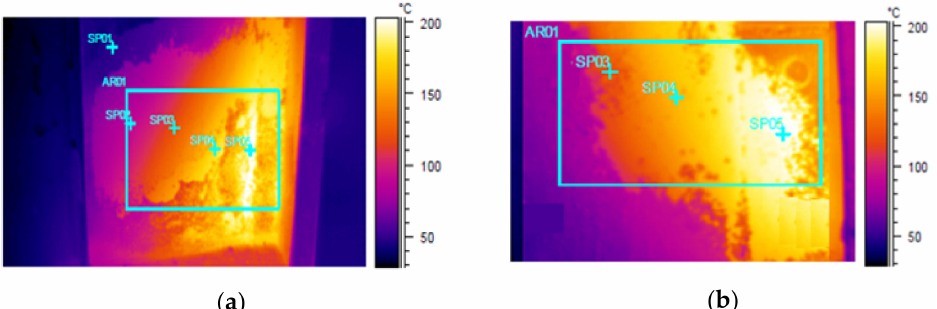
Figure 11. Thermograms of the steel-pouring ladle (with the area of the lining burnout). ( a ) part 1, ( b ) part 2.